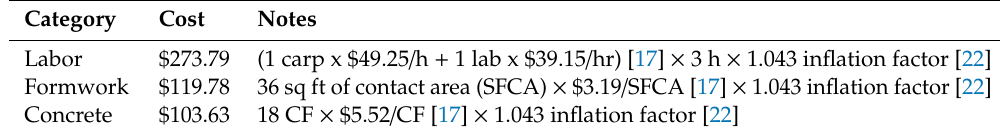
Table 3. Cost Breakdown of Dragon’s Tooth Using Conventional Construction.